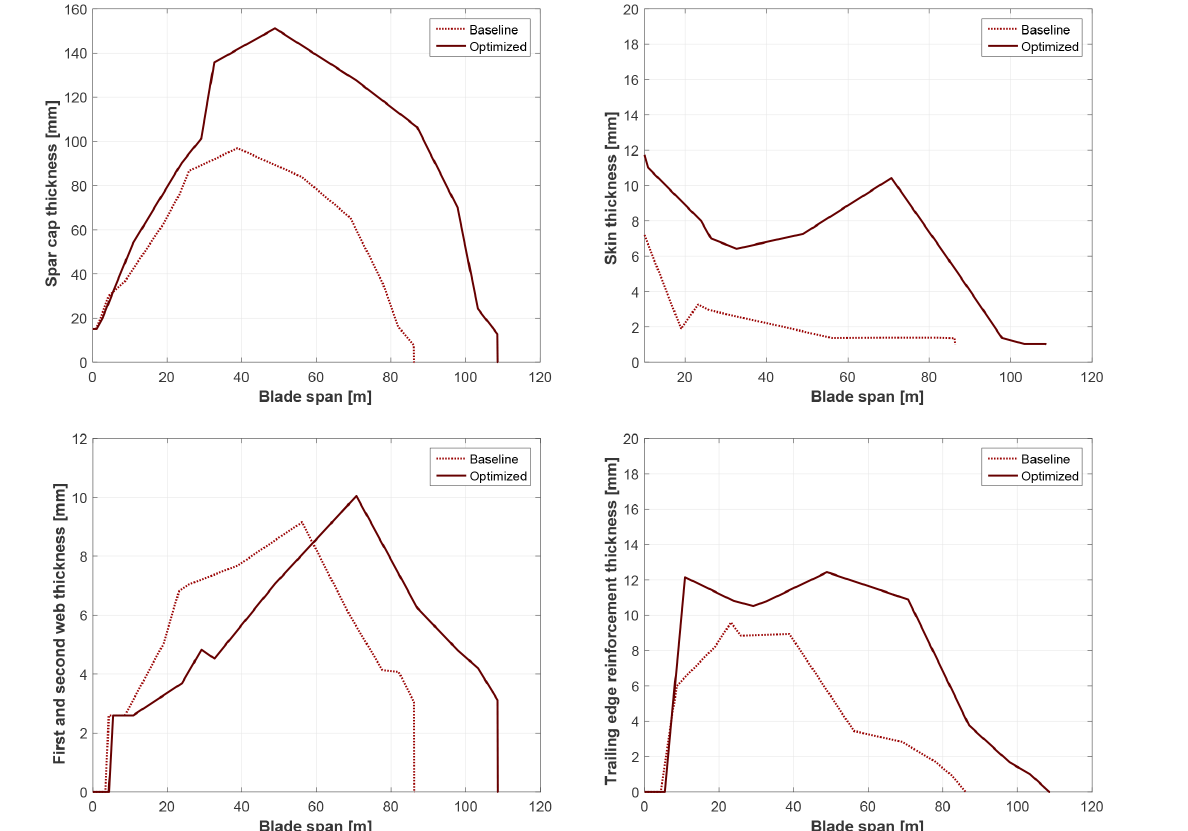
Figure 9. Structural thickness distributions of the baseline and the optimized 10MW wind turbine blades.